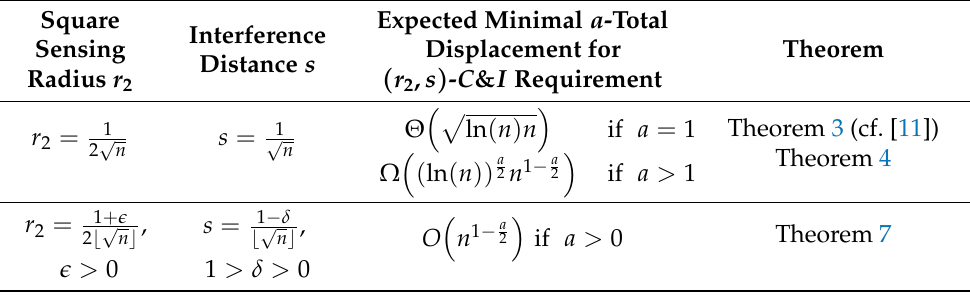
Table 2. The expected minimal a -total displacement of n random sensors on the unit square [ 0,1 ] 2 as a function of the square sensing radius r 2 and the interference value s , where (cid:101) > 0, 1 > δ >